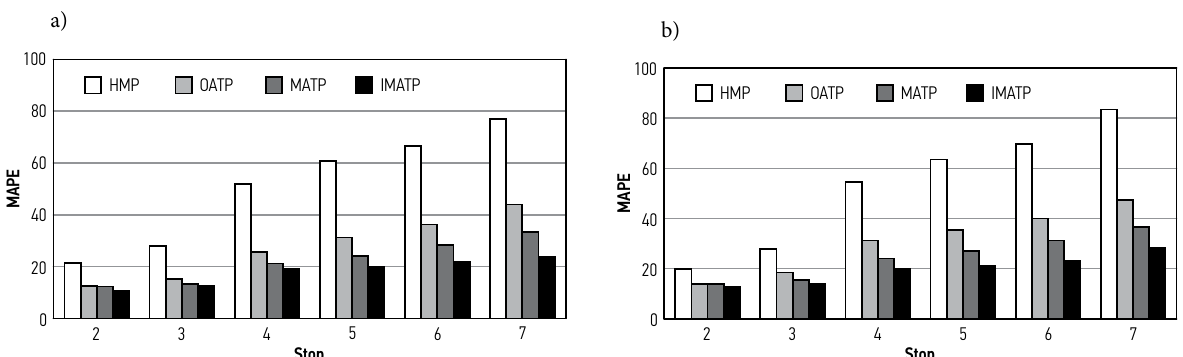
Fig. 8. A comparison of the MAPEs of four methods: a – peak period; b – off-peak